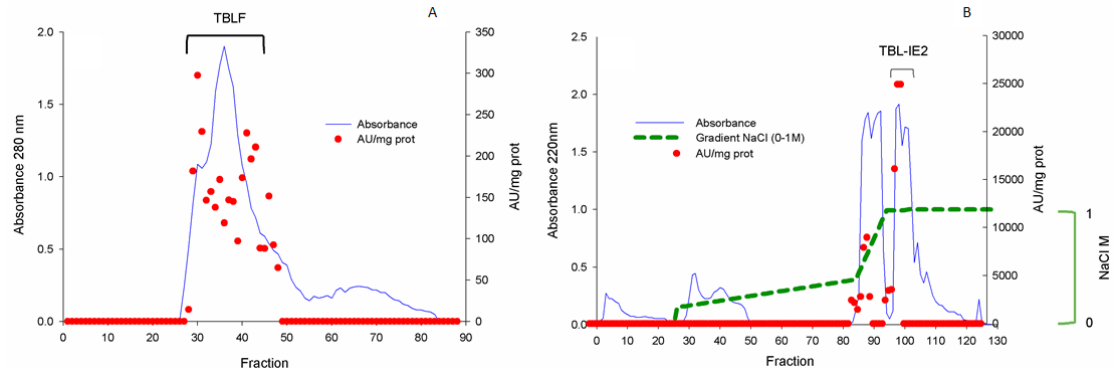
Figure 1. Chromatographic separation of the TBL-IE2 fraction. ( A ) Molecular size exclusion chromatography (Sephadex G-75). Red dots indicate fractions with agglutination activity (units per mg of protein), and the blue line shows the absorbance of the protein at 280 nm. TBLF is shown at the top. ( B ) Ion-exchange chromatography. Red dots indicate the fractions’ agglutination units per mg of protein, the absorbance at 220 nm of the protein fractions is shown in blue, and the green line marks the gradient from 0 to 1 M NaCl. The second peak, named TBLF-IE2, is indicated at the top.